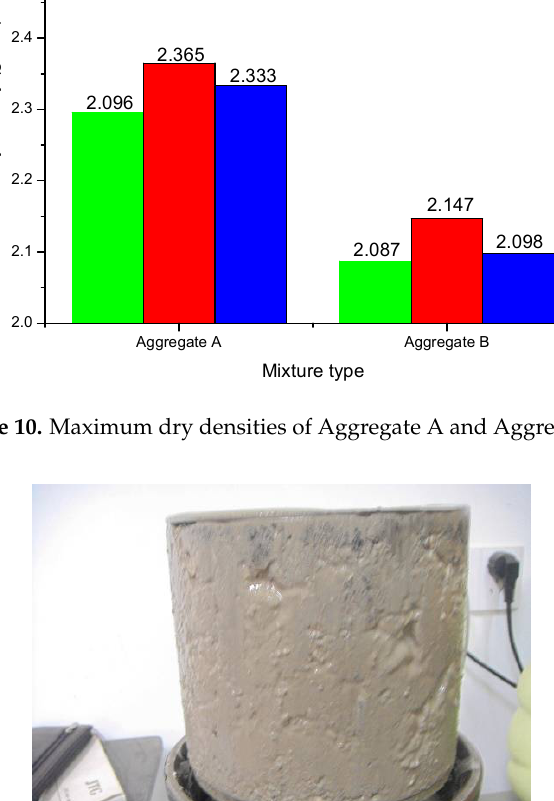
Figure 11. Specimen appearance under gyration compaction. 4.2.3. Unconfined Compressive Strength The specimens were cured under standard conditions (temperature of 20 ± 2 °C and relative humidity over 95%) for six days and immersed in water for one day. After that, the specimens were compressed using a pavement strength tester (Cangzhou Luyi experiment instrument Co., Ltd., Cangzhou, China). The unconfined compressive strength results of Aggregate A and B are shown in Figure 12.